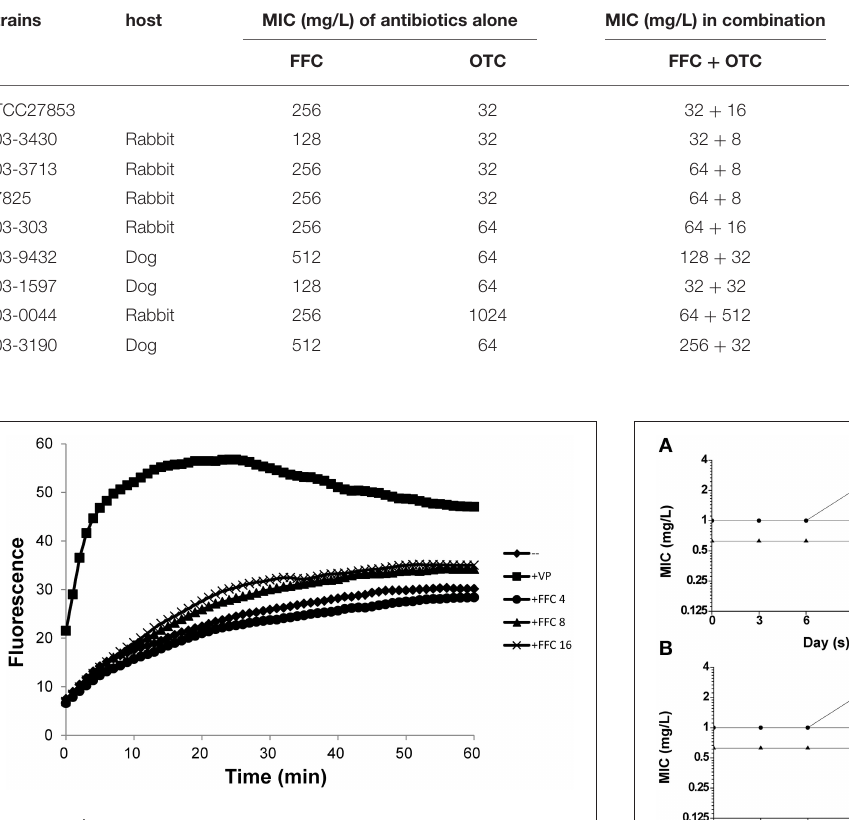
FIGURE 6 | Accumulation of ethidium bromide by P. multocida in the addition of increasing concentrations (mg/L) of florfenicol (FFC) at